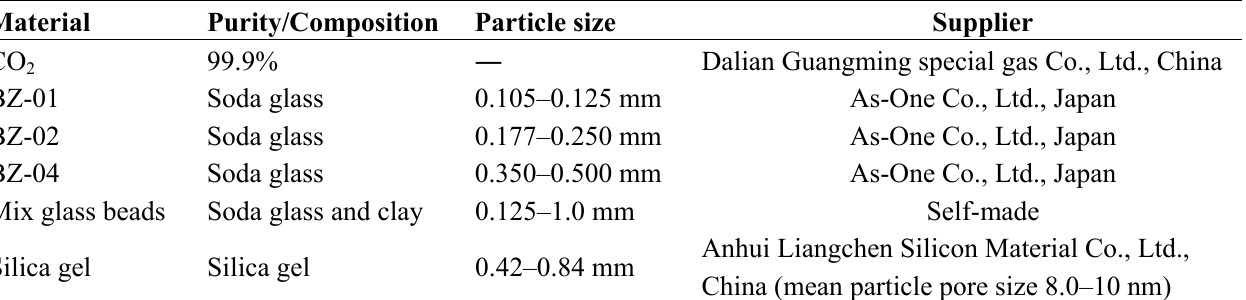
Table 1. Property and supplier of